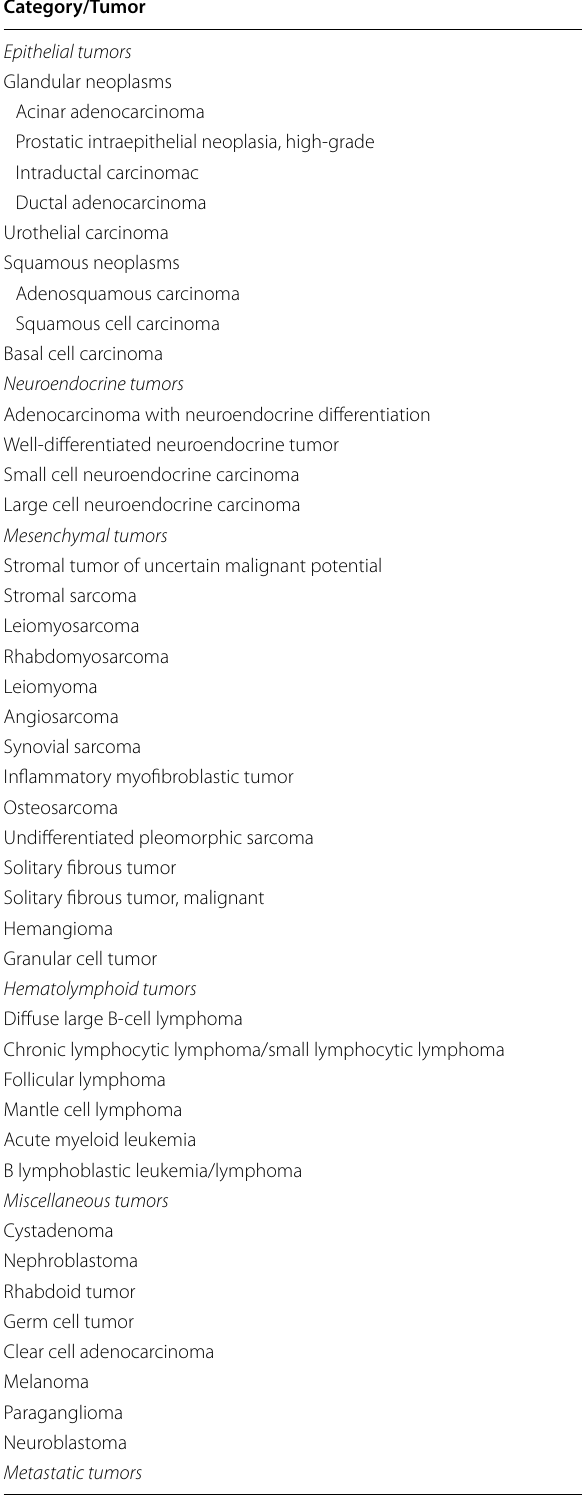
Table 1 World Health Organization classification of tumors of the